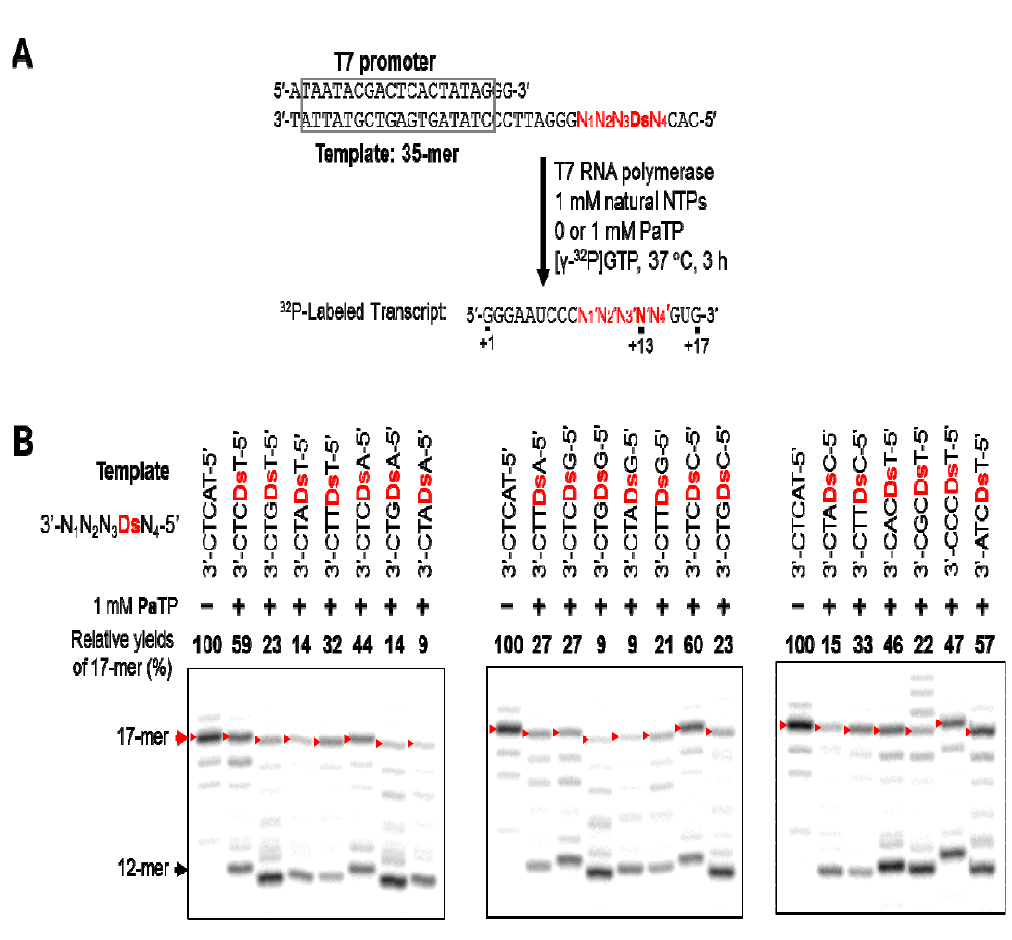
Figure 6. T7 transcription mediated by the Ds – Pa pair for 17-mer transcripts. ( a ) Scheme of the experiments. ( b ) Gel electrophoresis of transcripts generated from templates with different sequences around Ds , with natural NTPs (1 mM), in the presence or absence of Pa TP (1 mM). Transcripts were labeled at their 5 ′ -termini with [ γ - 32 P]GTP. The positions of the full-length 17-mer products are indicated by red arrows. Due to the different sequence contexts, the mobilities of the transcripts differed. The relative yield of each full-length transcript was determined by comparison to the yield of the native transcript from the template consisting of the natural bases only. The black arrow indicates the approximate position of the 12-mer transcripts, which paused at the previous position of Ds in the template. The experiments were independently repeated three times, and representative data are